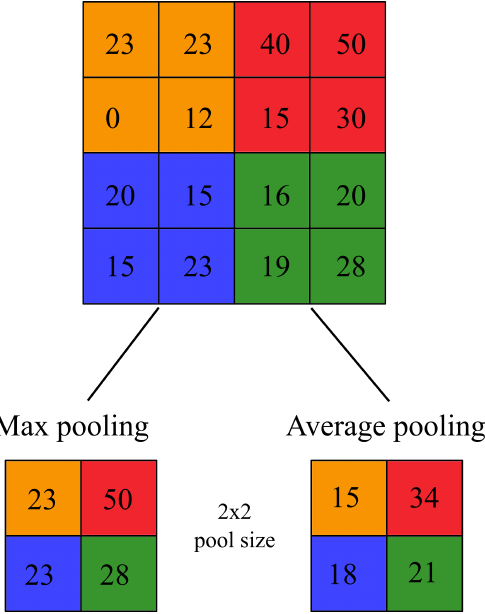
Figure 2. Example of max pooling and average